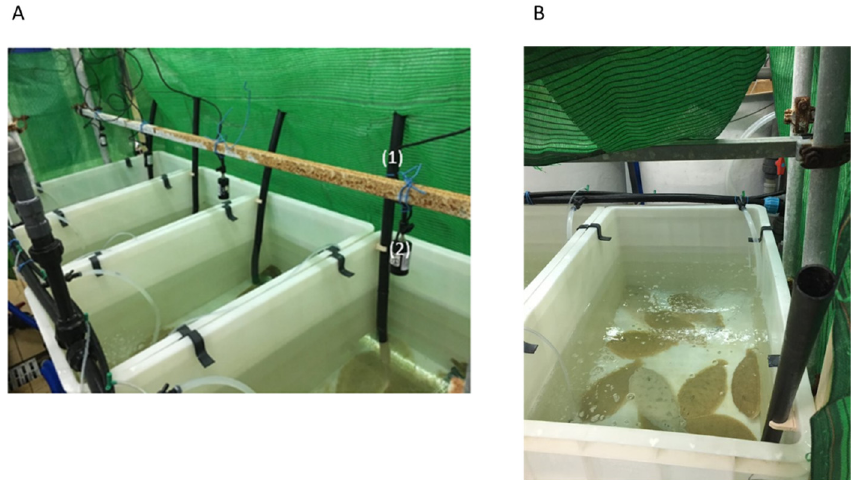
Figure 1. Experimental structure to conduct dominance test in Senegalese sole juveniles. ( A ) View from the inside with the shade cloth down. (1) Feeding tube and (2) Digital camera. ( B ) View from the front of the tank; note the feeding tube.